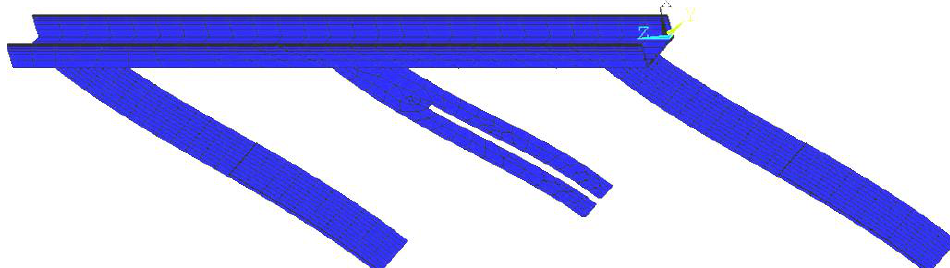
Figure 4. Illustration of the first mode shape of the prototype calculated by finite element